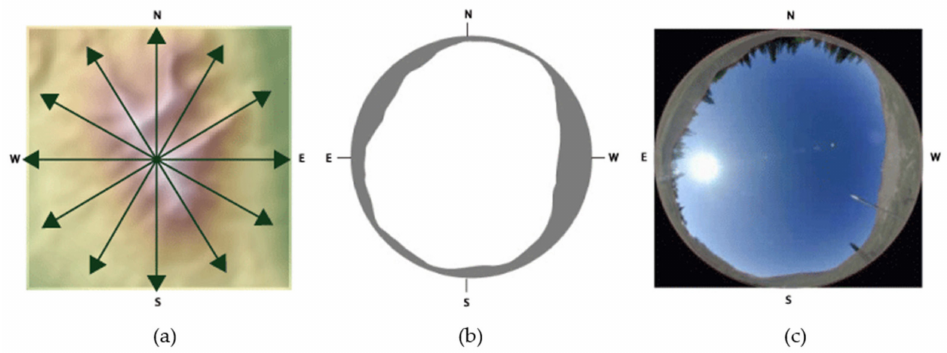
Figure 13. Subsequent stages of calculating the viewshed model for one DTM cell: ( a ) illustration of directions from a given location, ( b ) obscuring model (the visible part of the sky is shown in white, invisible in grey), ( c ) the obtained model superimposed on a semicircular photograph of the sky [77].